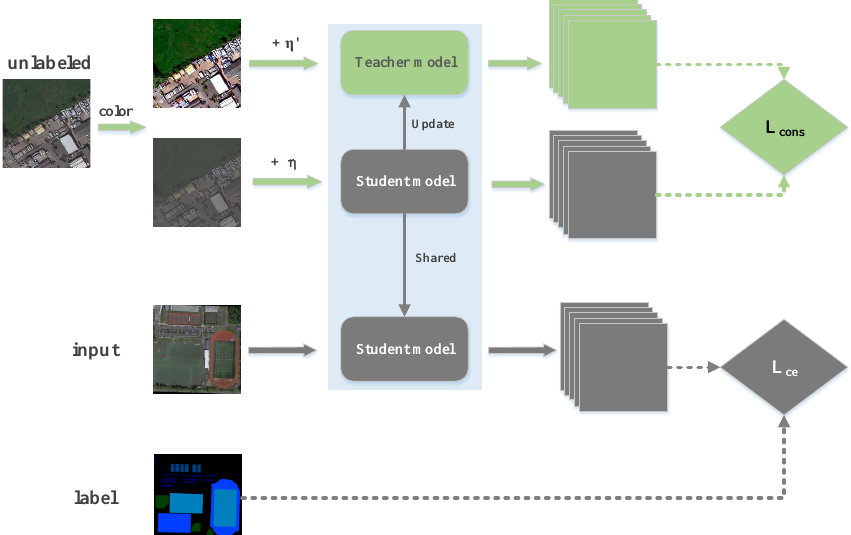
Figure 1. The main framework of our proposed consistency regularization (CR) training method. The parameters of two student models are shared between the supervised and unsupervised parts. The teacher model is updated according to the changes of student model. The final optimization loss consists of regularized loss and cross entropy